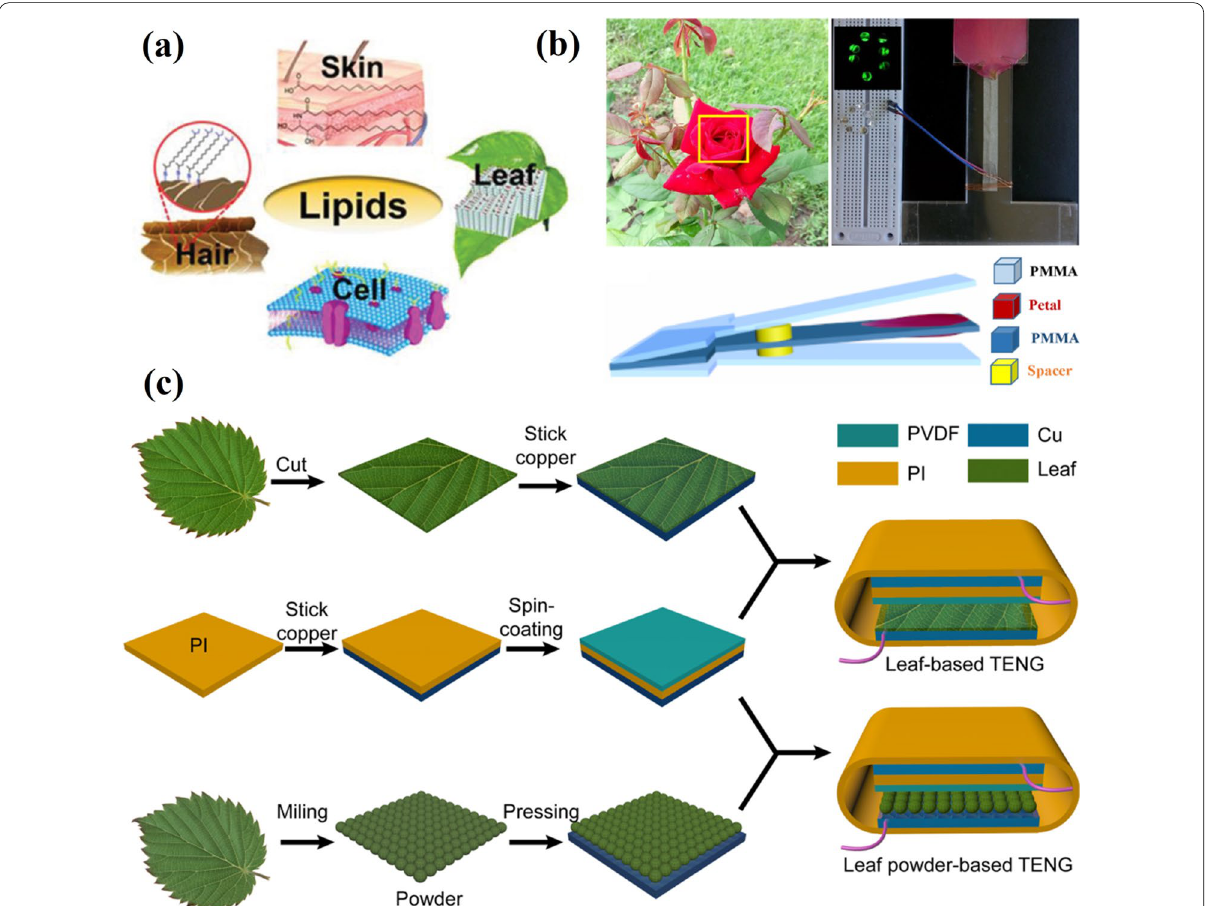
Fig. 5 TENGs based on regenerative natural substances: a lipid layers on natural regenerative surfaces. (Reproduced with permission from Ref. [44]); b a preparation of the biodegradable plant leaf and leaf powder-based TENGs. (Reproduced with permission from Ref. [45]); c TENG based on Chinese red rose. (Reproduced with permission from Ref.